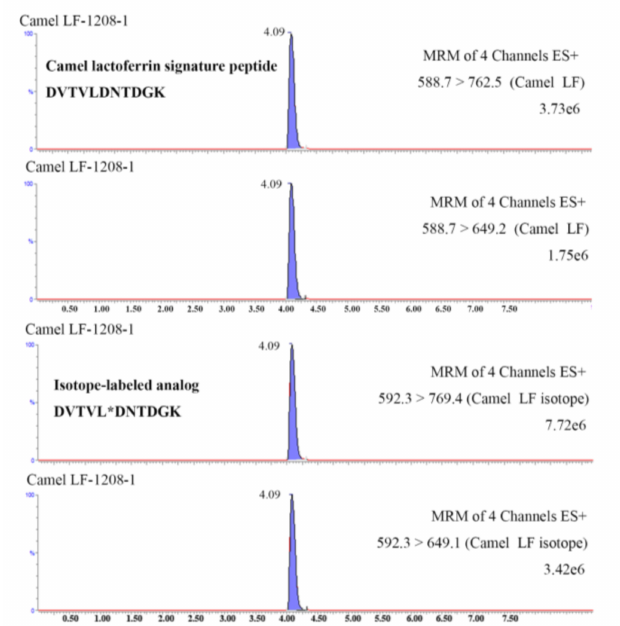
Figure 4. UHPLC-MS / MS chromatograms of camel lactoferrin signature peptide DVTVLDNTDGK (B) and its corresponding isotope-labeled analog DVTVL*DNTDGK in a tryptic dairy